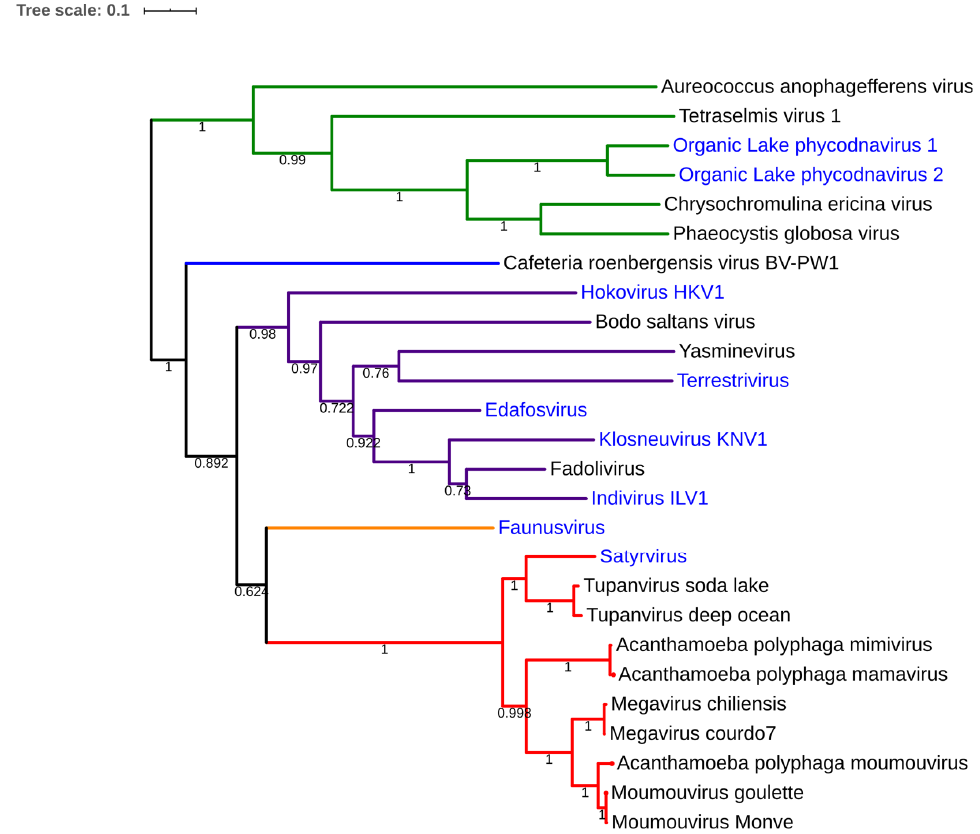
Figure 5. Maximum-likelihood tree based on the RNA polymerase subunit 1 of Mimiviridae . Red color indicates nodes containing mimivirus lineages A, B and C and Tupanviruses, orange was used for Faunusvirus, purple for Klosneuvirinae, Blue for Cafeteria roenbergensis virus, green